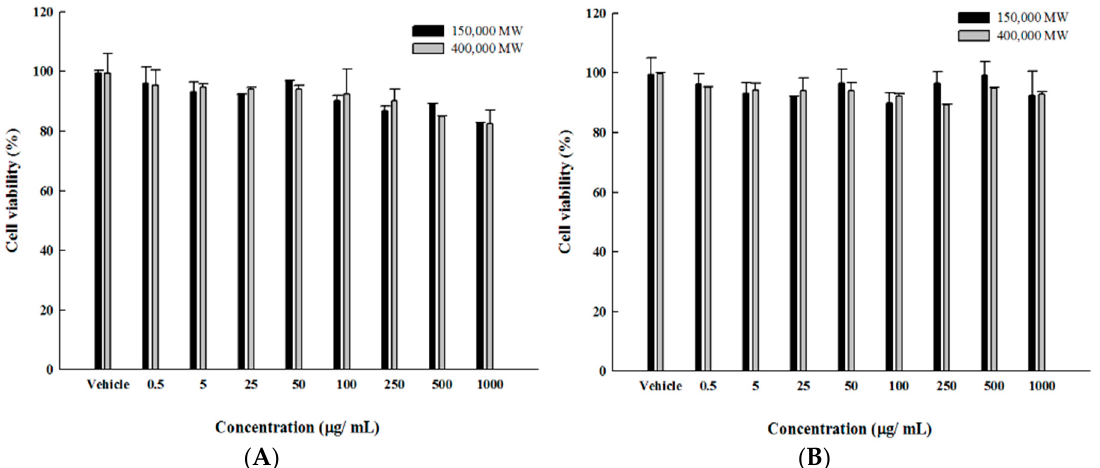
Figure 7. The cell viability of the SPIO NPs–chitosan composite particles in ( A ) 3T3 Cell line and ( B ) MCF-7 cell line.